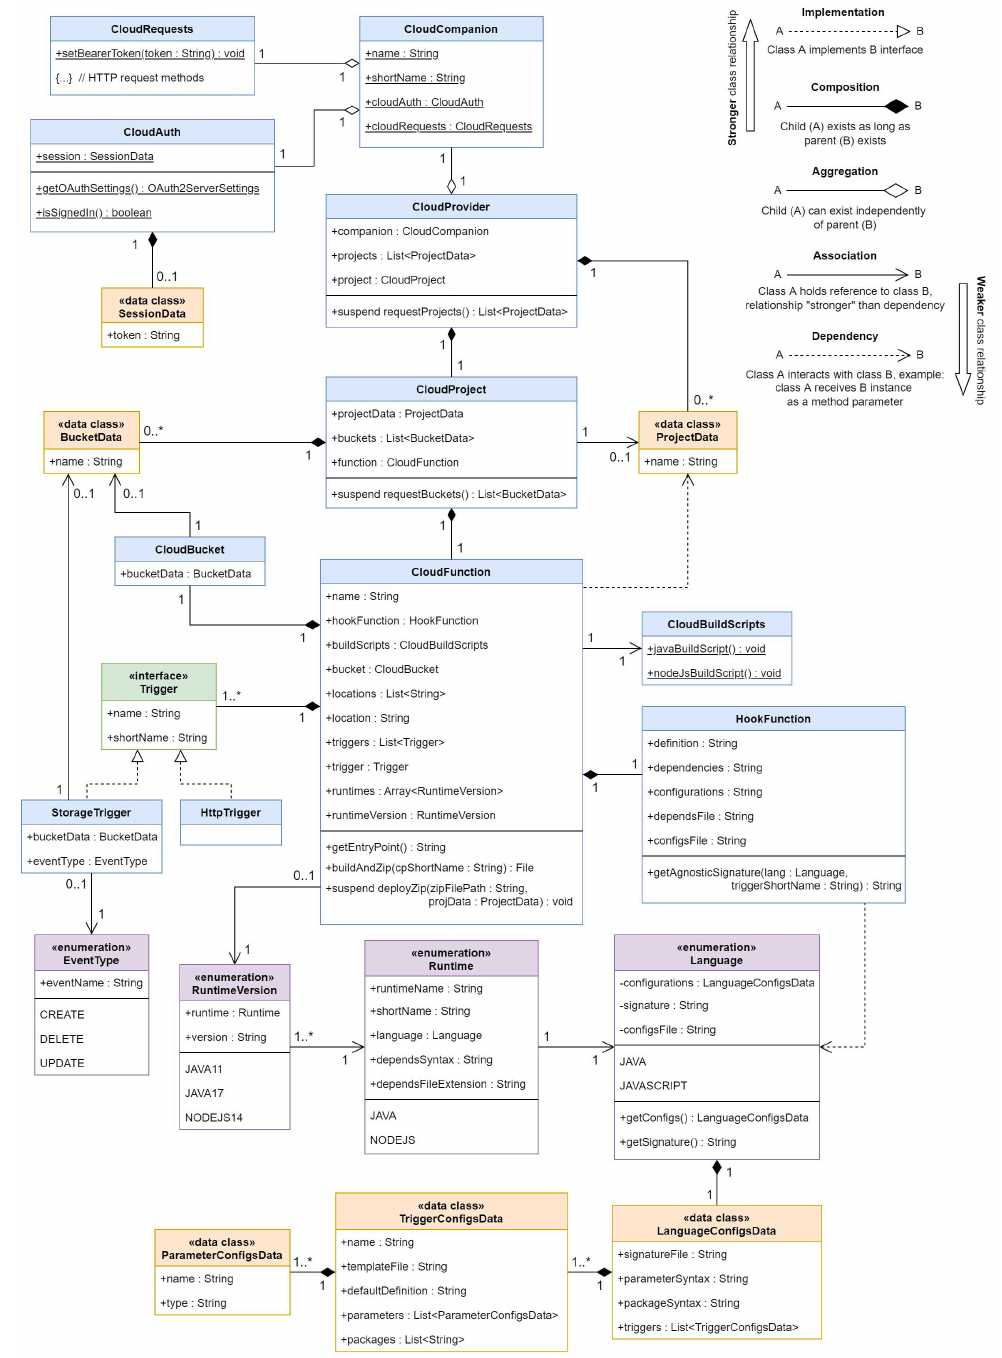
Figure A1. Uniform programming